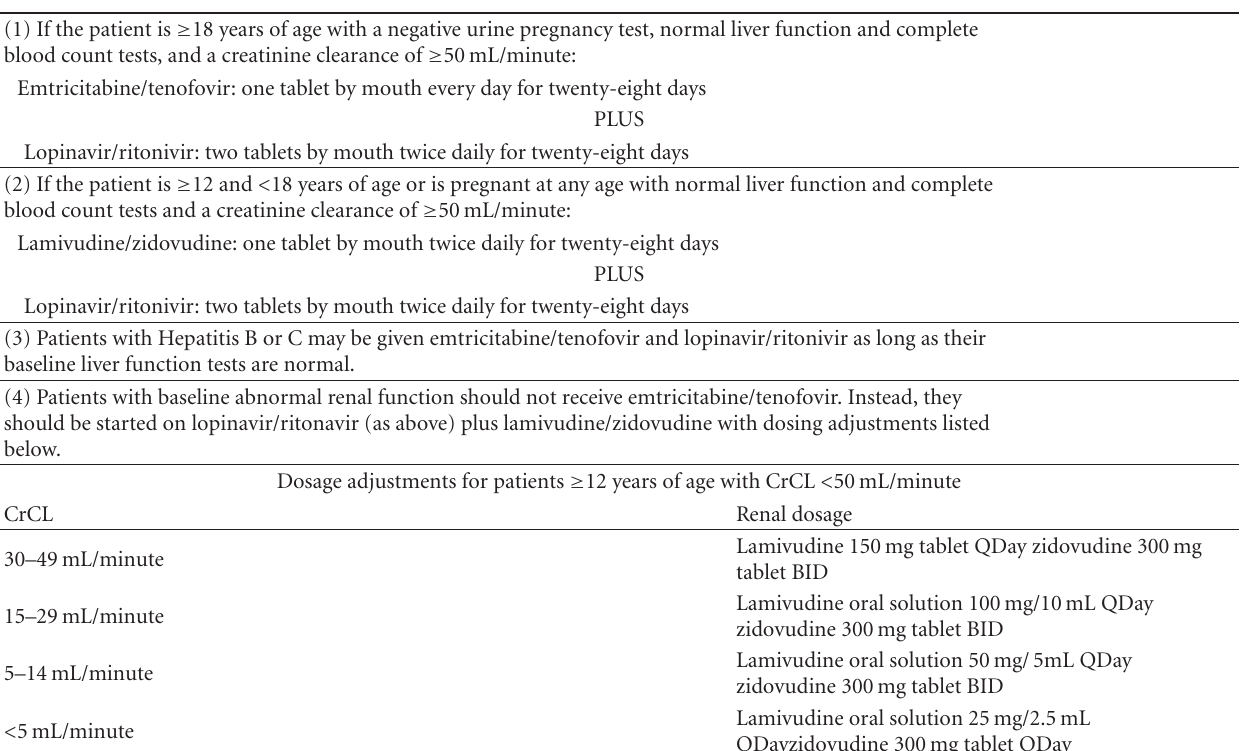
Table 3: HIV nPEP antiviral medications